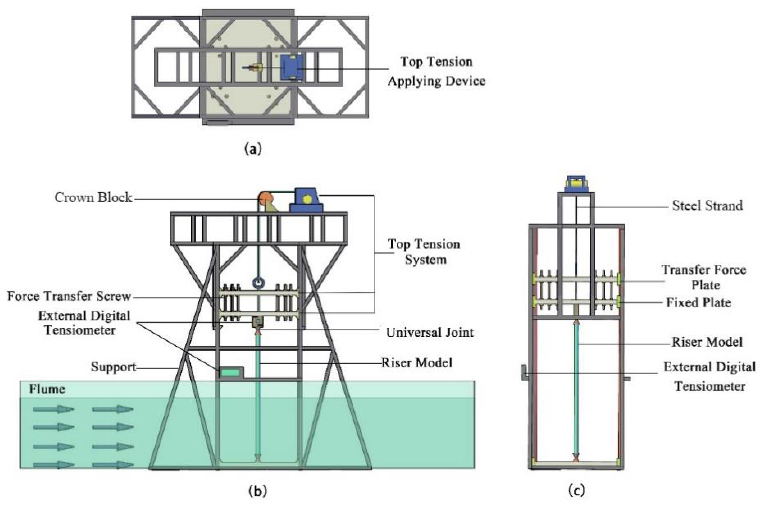
Figure 2. General setup of the experiment ( a ) Top view; ( b ) Elevation view; ( c ) Side view.